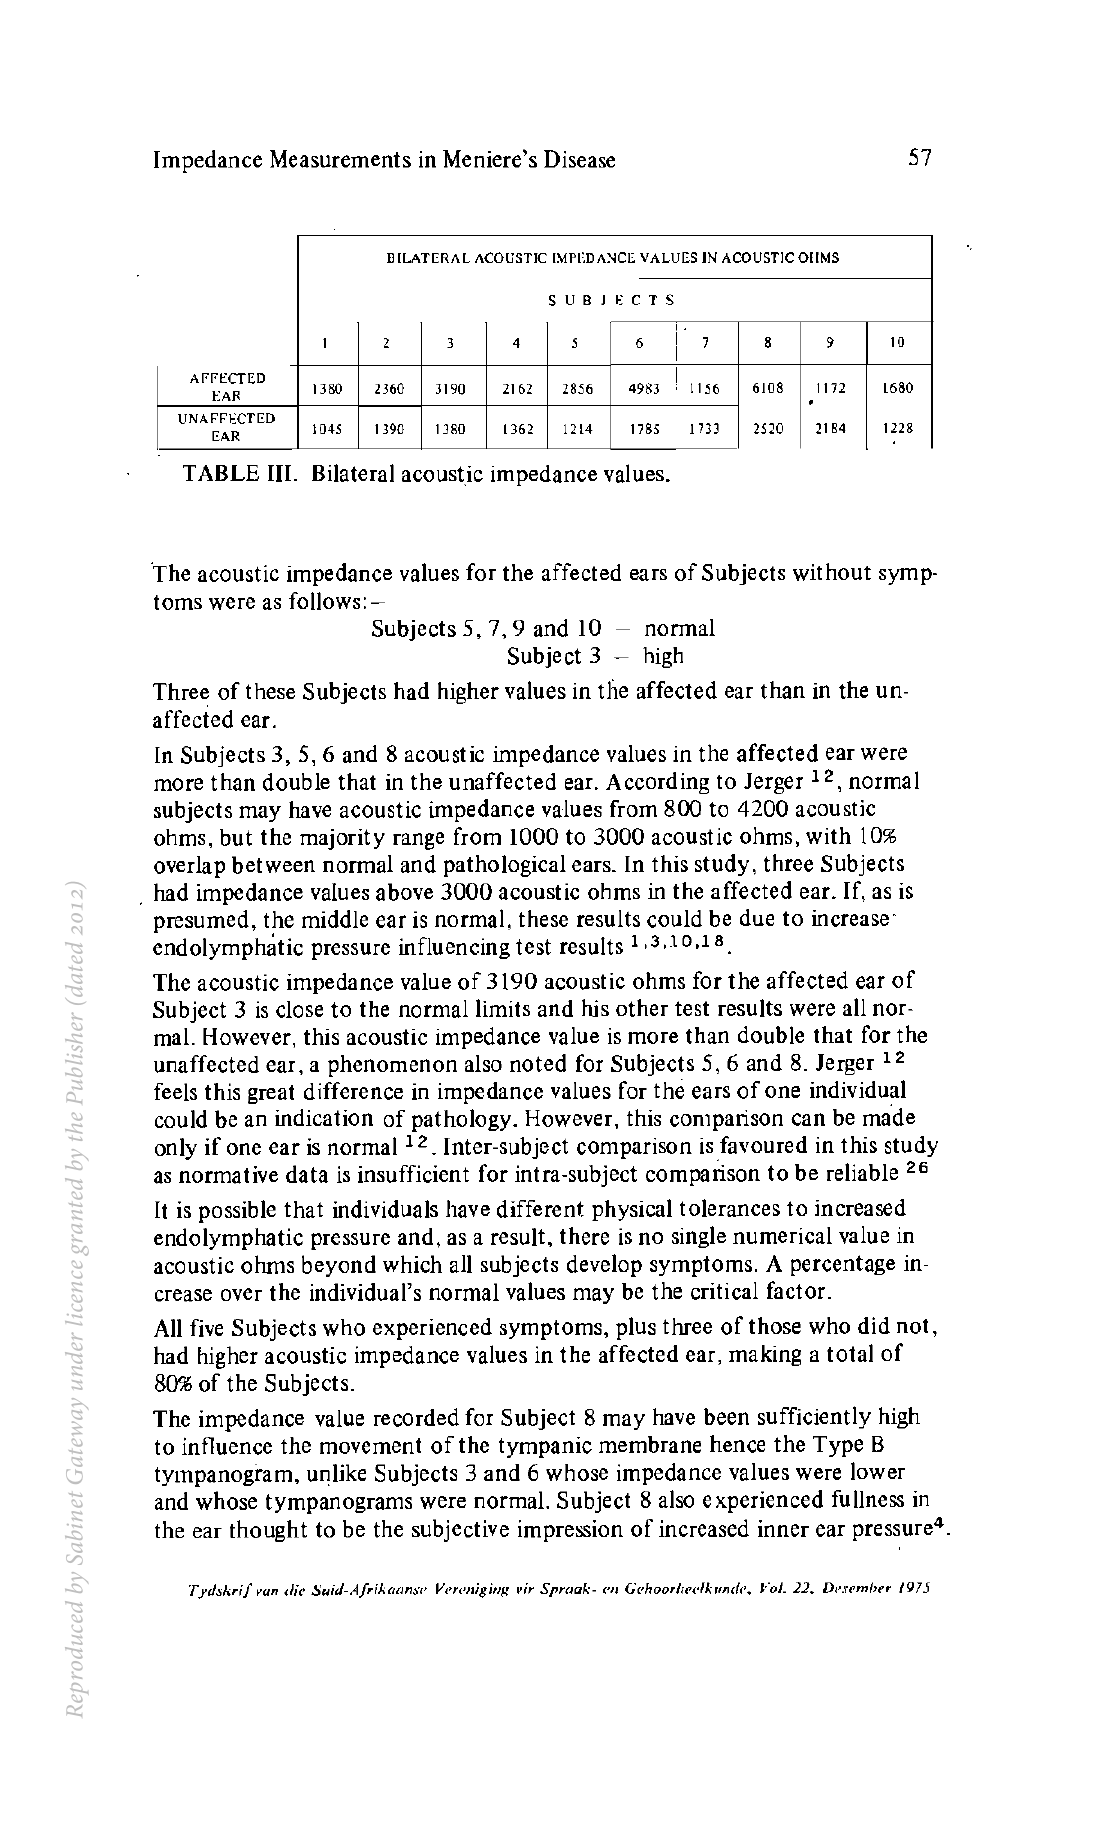
TABLE III. Bilateral acoustic impedance values.